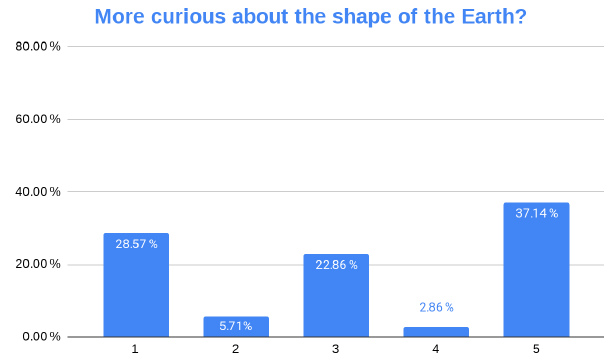
Figure 4. Graphics (a) “what do you understand about the shape of the Earth?”, (b) “what do you know about universal gravitation?”, and (c) “what is heliocentric?”